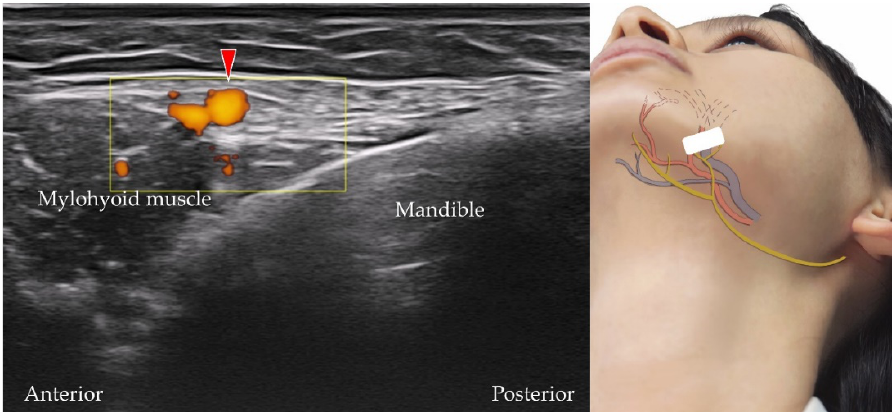
Figure 21. Power Doppler ultrasound imaging of the submental artery (red arrowhead) . White square , footprint of the ultrasound transducer.